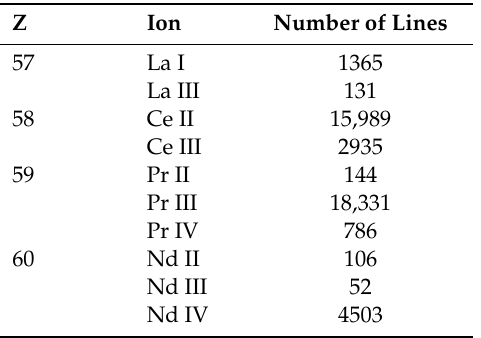
Table 3. Number of lines for which the radiative parameters (wavelengths, oscillator strengths and transition probabilities) are listed in the DREAM